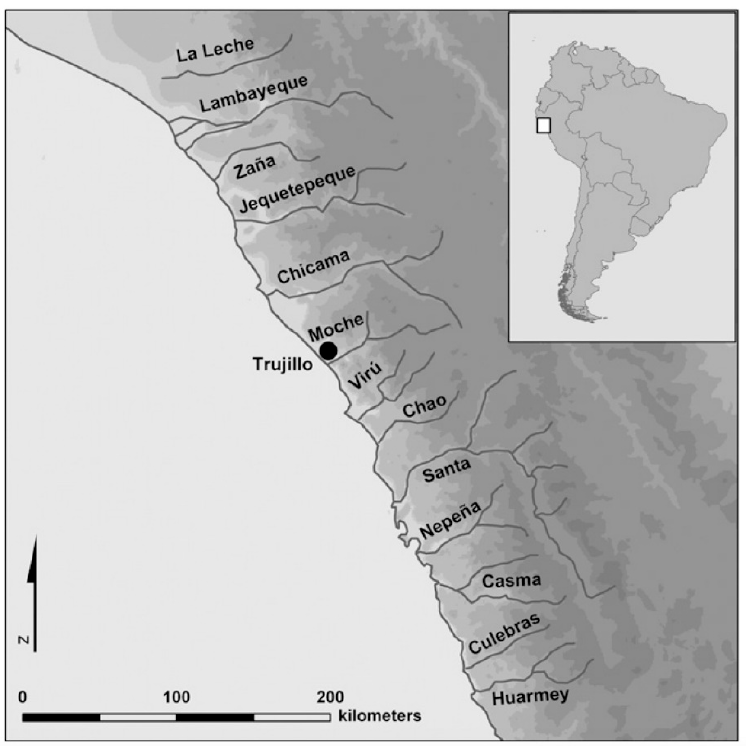
Figure 1. Map of the north coast of Peru (Adapted from Millaire 2010).